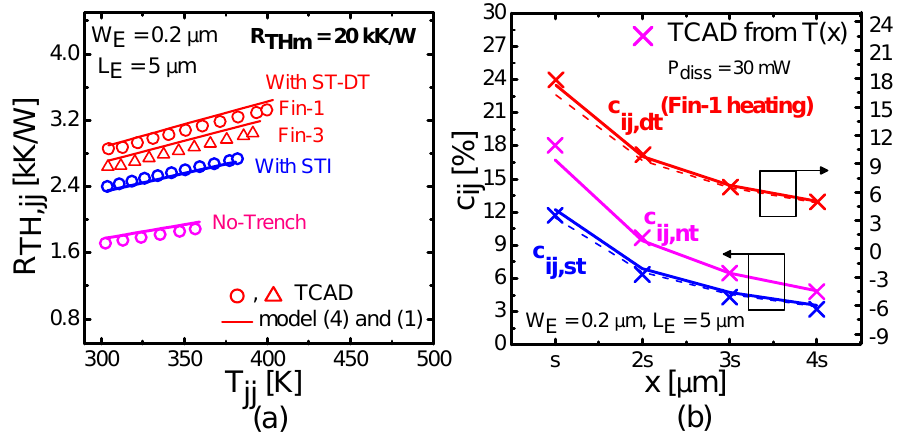
Figure 3. ( a ) T jj − dependent R TH , jj variation and ( b ) c ij at the sensing fingers: A comparison between TCAD results (symbols) and the proposed model (lines) for the three types of structures with A E = 0.2 × 5 µ m 2 and P diss = 30 mW. Solid lines in ( b ) correspond to the case when ∆ T ij , nt / ∆ T ij , st = 1 in c ij , st and c ij , dt model. Here finger spacing s = 2.5 µ